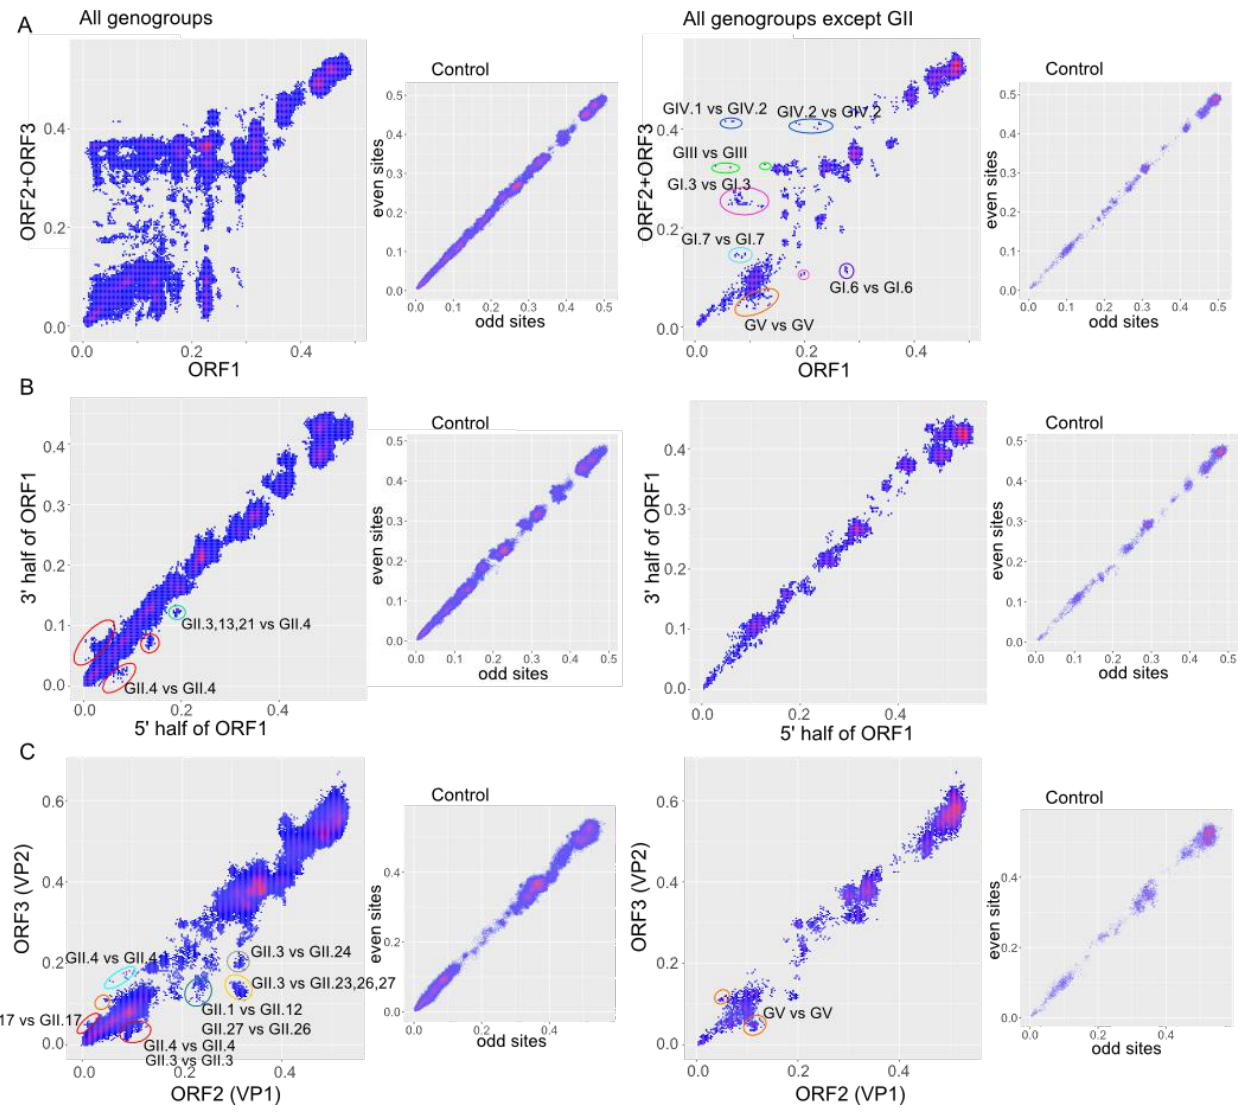
Figure 4. Correspondence between p-distances (PDC plots) between nonstructural (ORF1) and structural (ORF2, ORF3) genomic regions ( A ), within nonstructural genomic region (ORF1) ( B ), within structural genomic region ( C ) in all norovirus genogroups (left panel) and all genogroups except GII (right panel). The axes represent uncorrected p-distances in genomic regions considered. Control plots of correspondence between distances in even vs. odd positions in an alignment simulate PDC plots in absence of recombinant sequences in a dataset. Dots that correspond to virus pairs that underwent recombination and are discussed in the text are marked with circles.